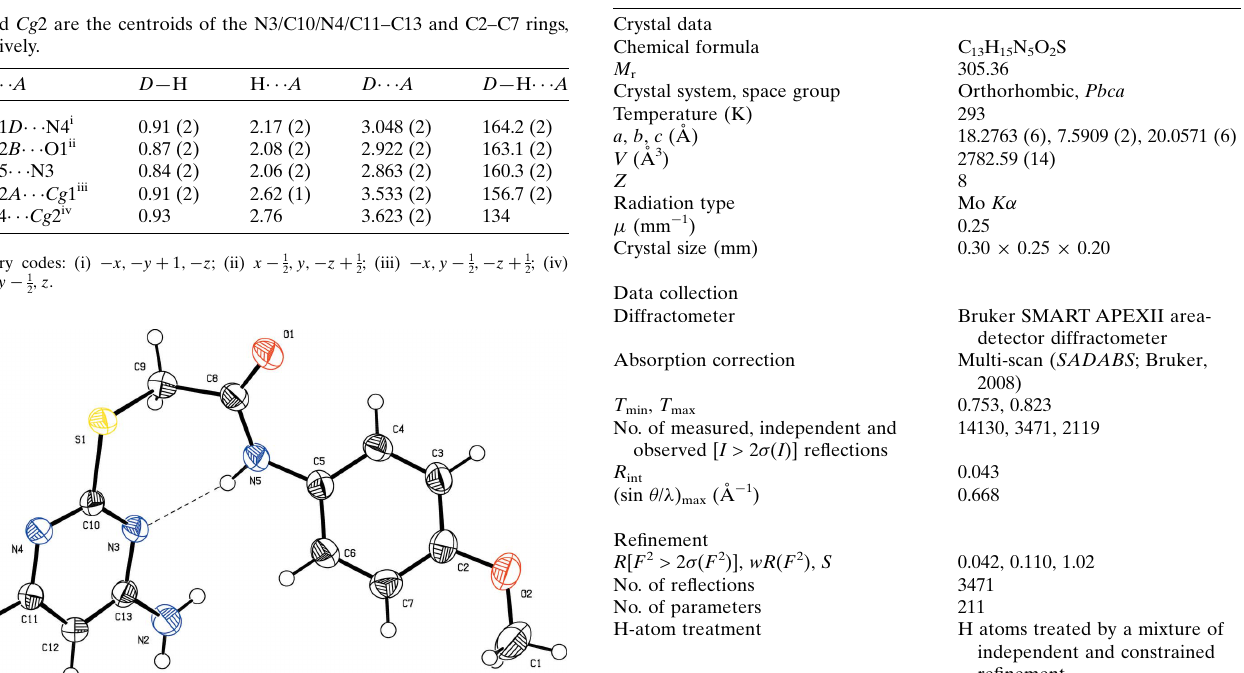
Table 2 Experimental